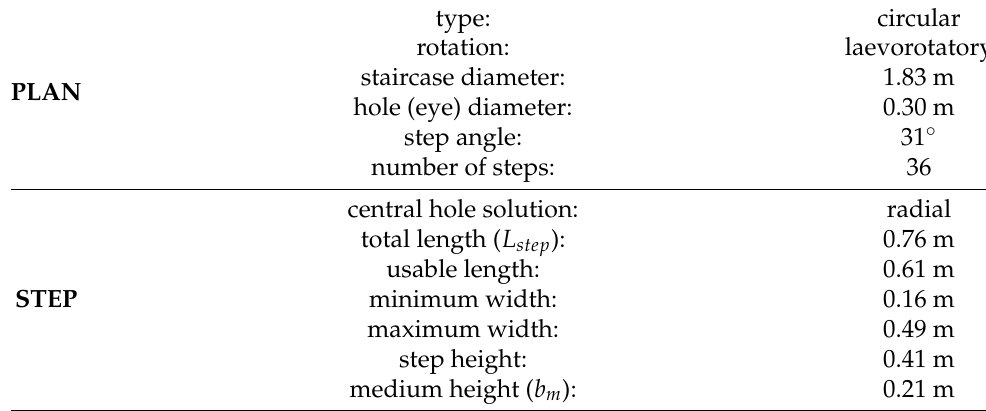
Table 1. Spiral staircase in the tower of Nisida: synthesis of the main metric and dimensional